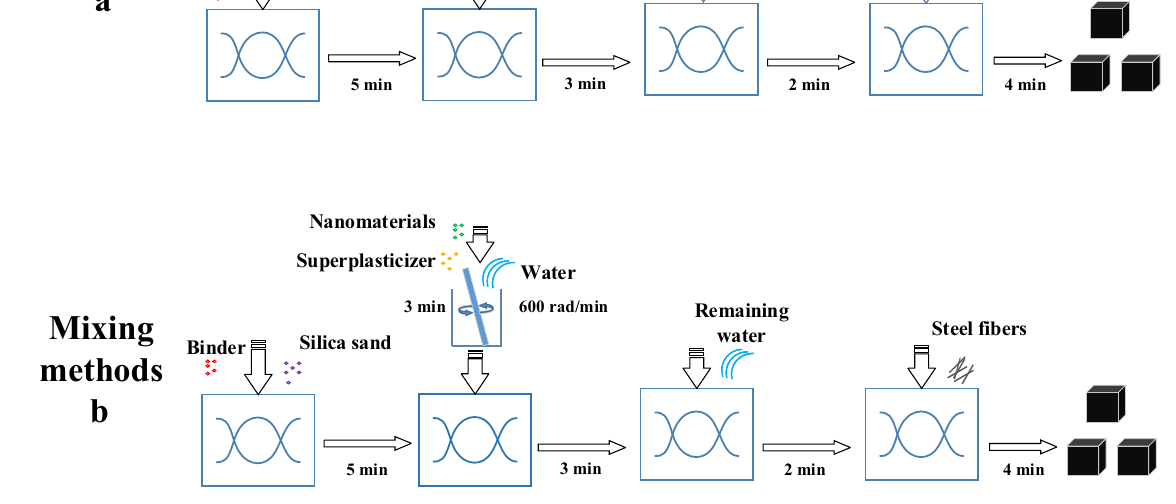
Figure 4: Mixing methods of UHPC.